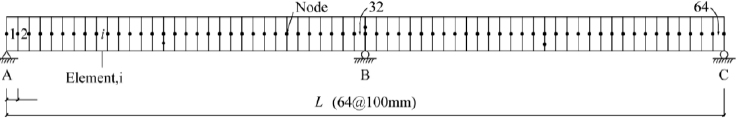
Figure 7. Division of longitudinal elements of continuous beams.